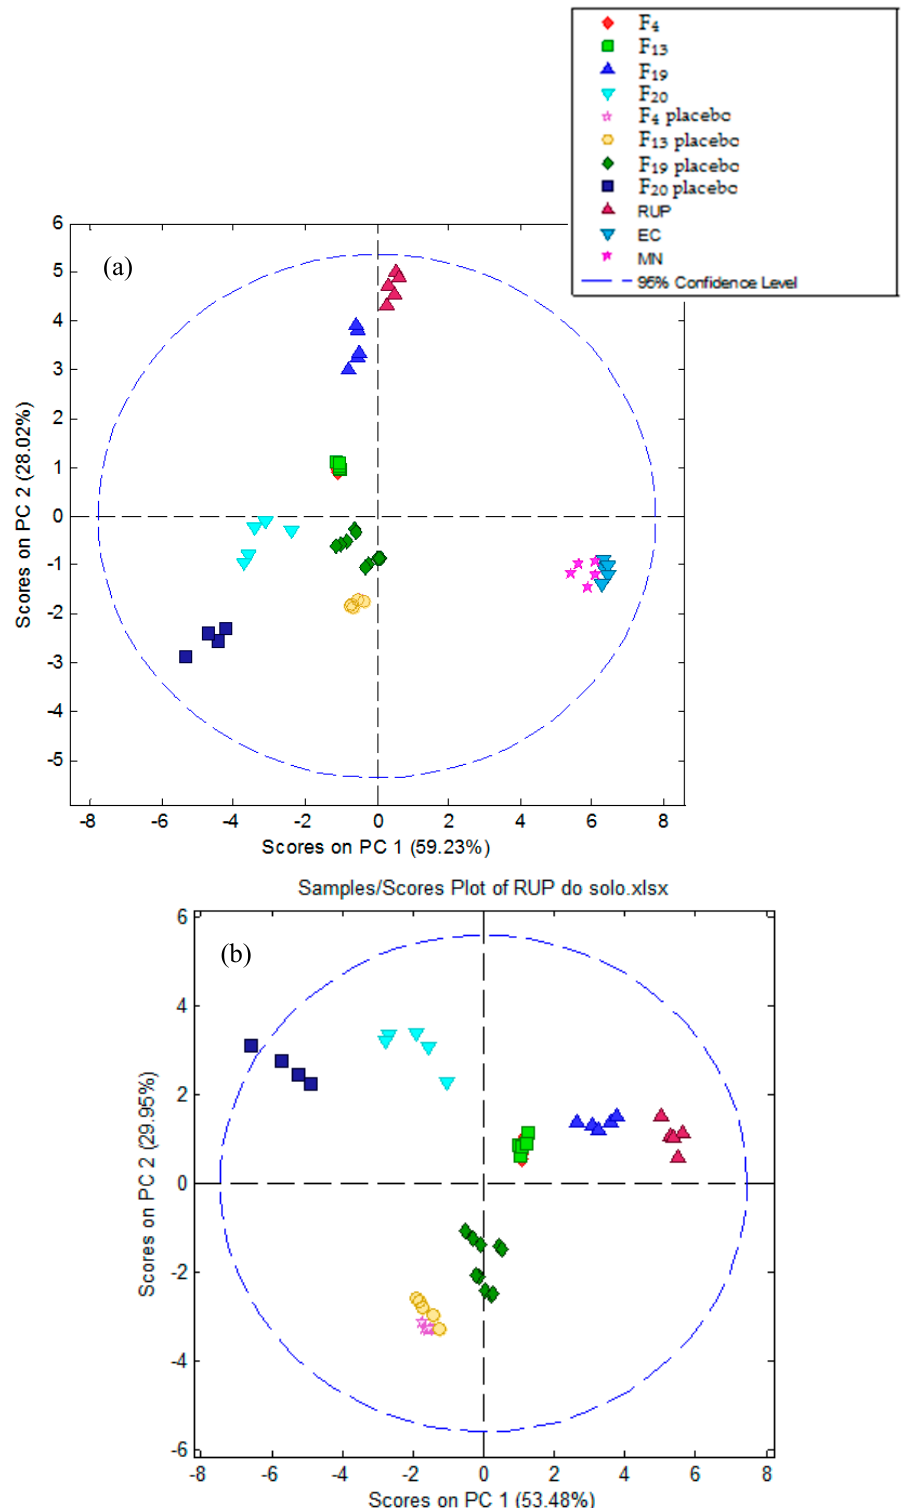
Figure 6. Principal component analysis (PCA) plots presenting taste clusters of: pure RUP, EC, MN, microparticle placebo and microparticle formulations F 4 , F 13 , F 19 , and F 20 ( a ) and pure RUP, microparticle placebo and microparticle formulations F 4 , F 13 , F 19 , and F 20 with the pure excipients exclusion ( b ).